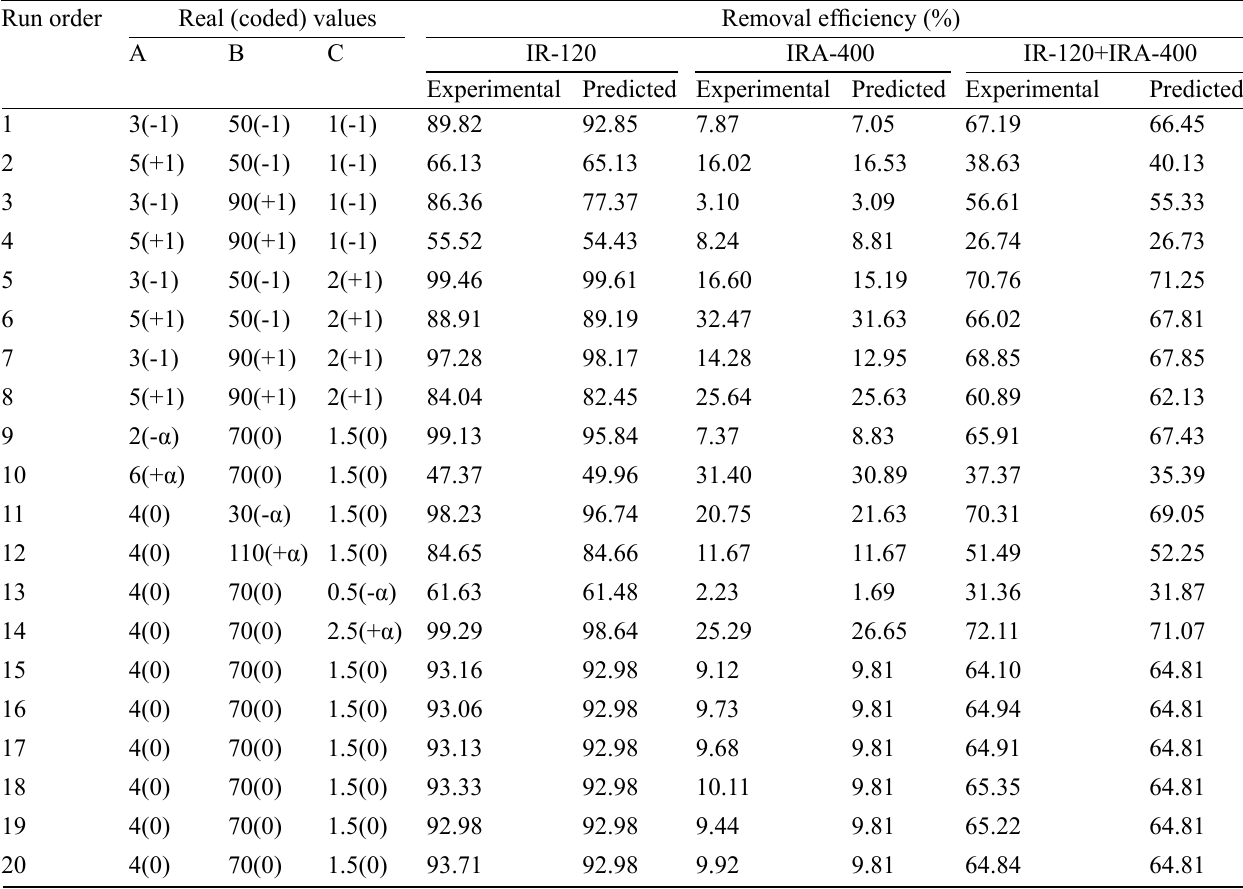
Table 3. Full factorial central composite design matrix of orthogonal and real values along with the observed responses for removal of